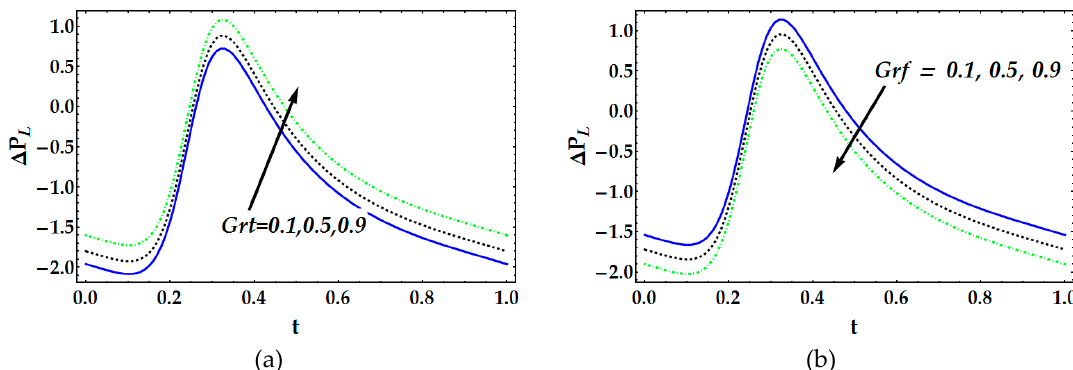
Figure 4. Pressure rise distribution for various values of Grt and G rf .